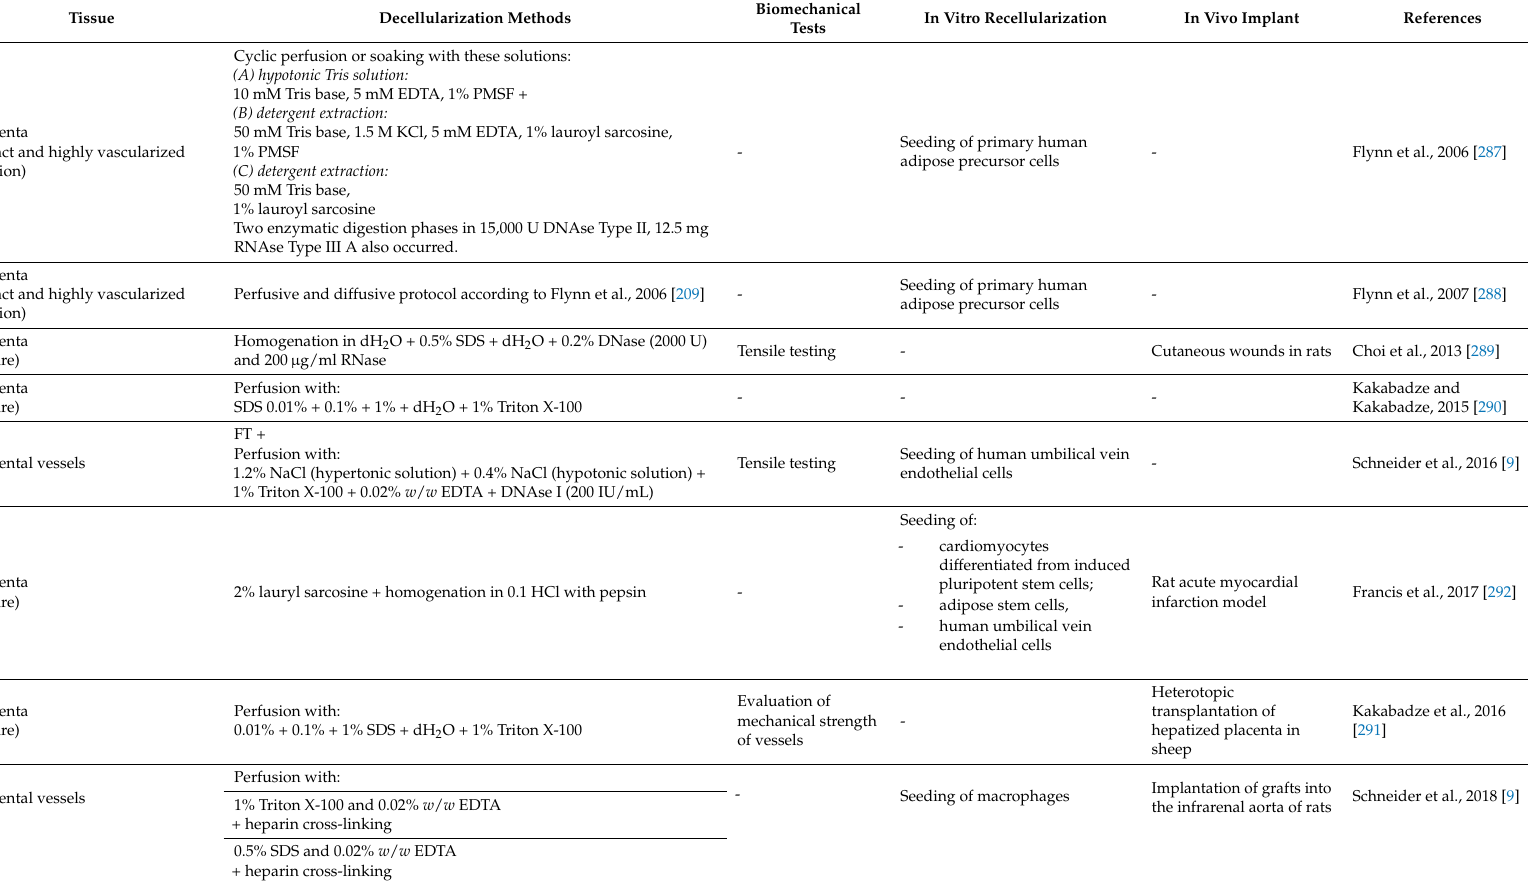
Table 12. Placenta. Decellularization techniques, biomechanical tests, recellularization methods, and in vivo implant of human placenta extracellular